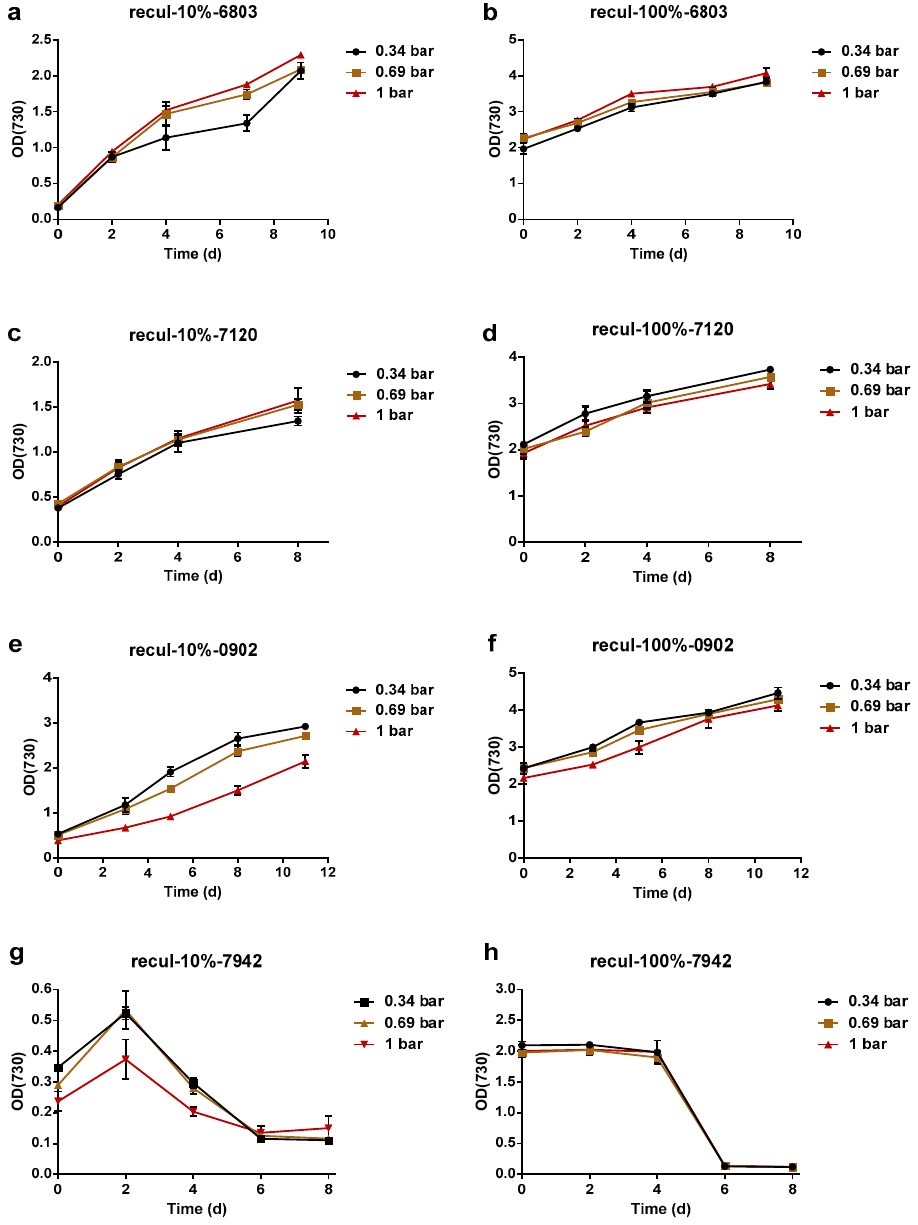
Figure 3. Cyanobacteria growth curves after filtration using an MF membrane; growth curves for Syn 6803 ( a , b ), Ana 7120 ( c , d ), Lep 0902 ( e , f ), and Syn 7942 ( g , h ). For the experiments whose data are shown in ( a , c , e , g ), 10 mL of circulating filtered cyanobacteria cultures was inoculated into 100 mL of fresh BG11 medium for re-culture after 95.5 min of filtration. For the experiments whose data are shown in ( b , d , f , h ), 100 mL of circulating filtered cyanobacteria cultures was directly used for re-culture after 95.5 min of filtration. Error bars represent the standard deviations of triplicates.